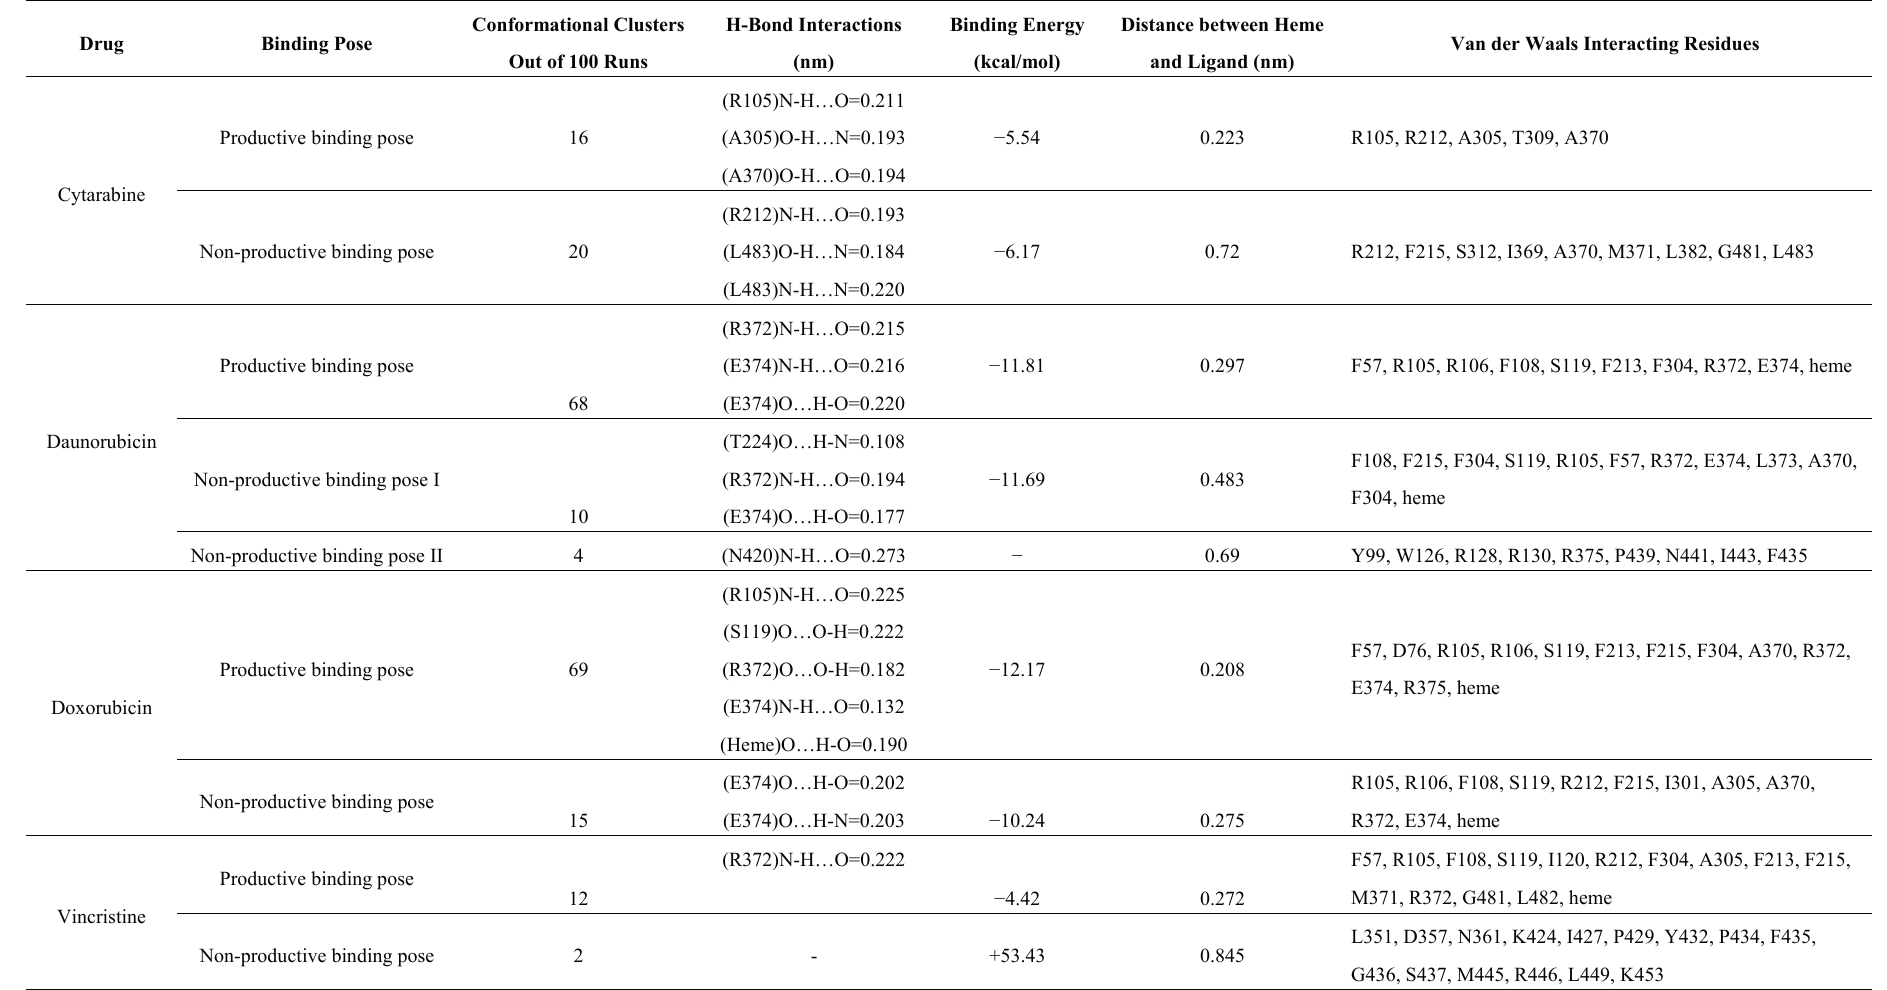
Table 1. Summary of molecular interactions of the drugs with